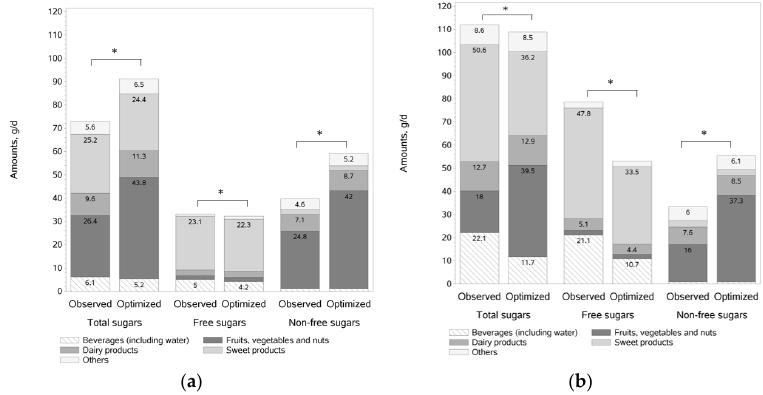
Figure 2. Amount of sugars (total, free, non ‐ free) 1 in observed and optimized diets (g/d), from main food category contributors in: FS ‐ ACCEPTABLE ( a ); and FS ‐ EXCESS ( b ) individuals 2 . 1 Amounts of sugars lower than 4 g not labeled; 2 For both FS ‐ ACCEPTABLE and FS ‐ EXCESS, total sugars, free sugars and non ‐ free sugars were significantly different between observed and optimized diets after adjustment for age, gender, energy intake, smoker status, BMI, socio ‐ professional status, composition of the family and sitting time.